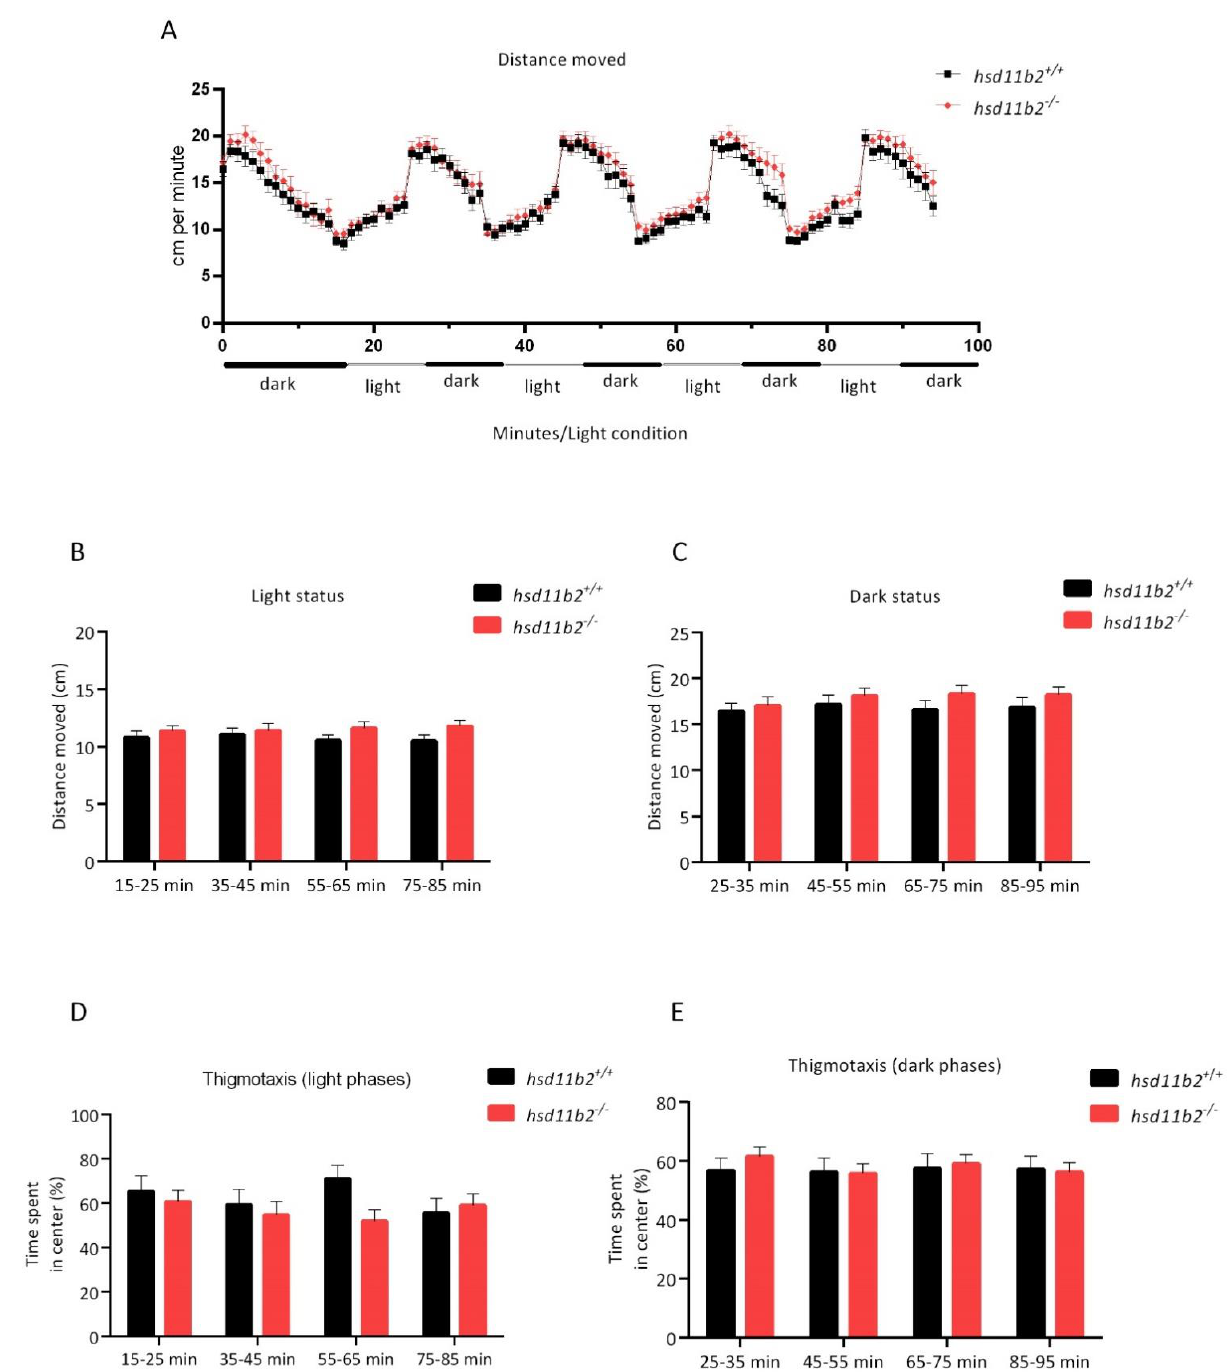
Figure 7. ( A ) Overview of the locomotor activity of zebrafish larvae of the two genotypes during four alternating phases of 0% and 5% light (139 lux). ( B ) Distance moved by zebrafish larvae of the two genotypes during four phases of 5% light (139 lux). ( C ) Distance moved by zebrafish larvae of the two genotypes during four phases of 0% light. ( D , E ) Percentage of the time spent in the “center” zone as an assessment of thigmotaxis ( D ) during four phases of 5% light and ( E ) four phases of 0% light. No statistically significant difference was observed. Holm-Sidak comparison test was applied to identify groups that were significantly different. * p < 0.05.